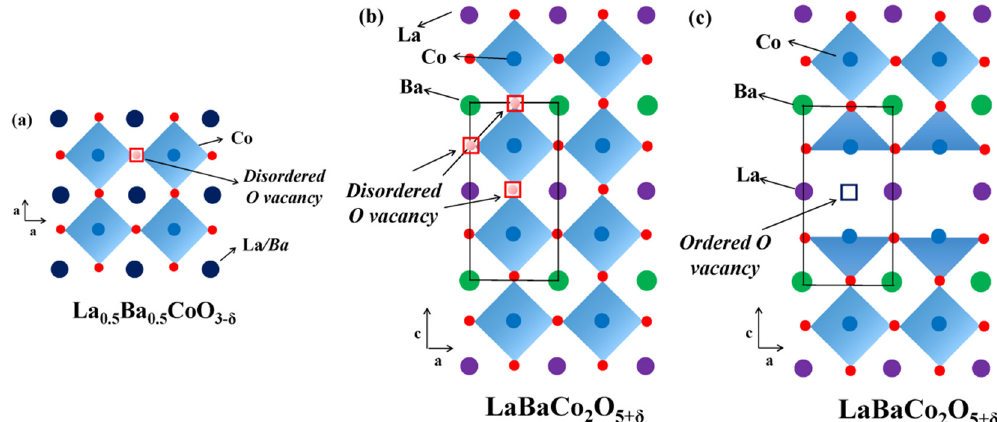
Figure 3. Crystal structures of ( a ) cubic Pm 3 m single perovskite La 0.5 Ba 0.5 CoO 3– δ ; ( b ) tetragonal P 4/ mmm ordered A-site cation and disordered oxygen-vacancy double perovskite LaBaCo 2 O 5+ δ ; ( c ) orthorhombic Pmmm both an ordered A-site cation and ordered oxygen-vacancy double perovskite LaBaCo 2 O 5+ δ (reproduced with permission from [56]. Copyright 2016, Multidisciplinary Digital Publishing Institute).